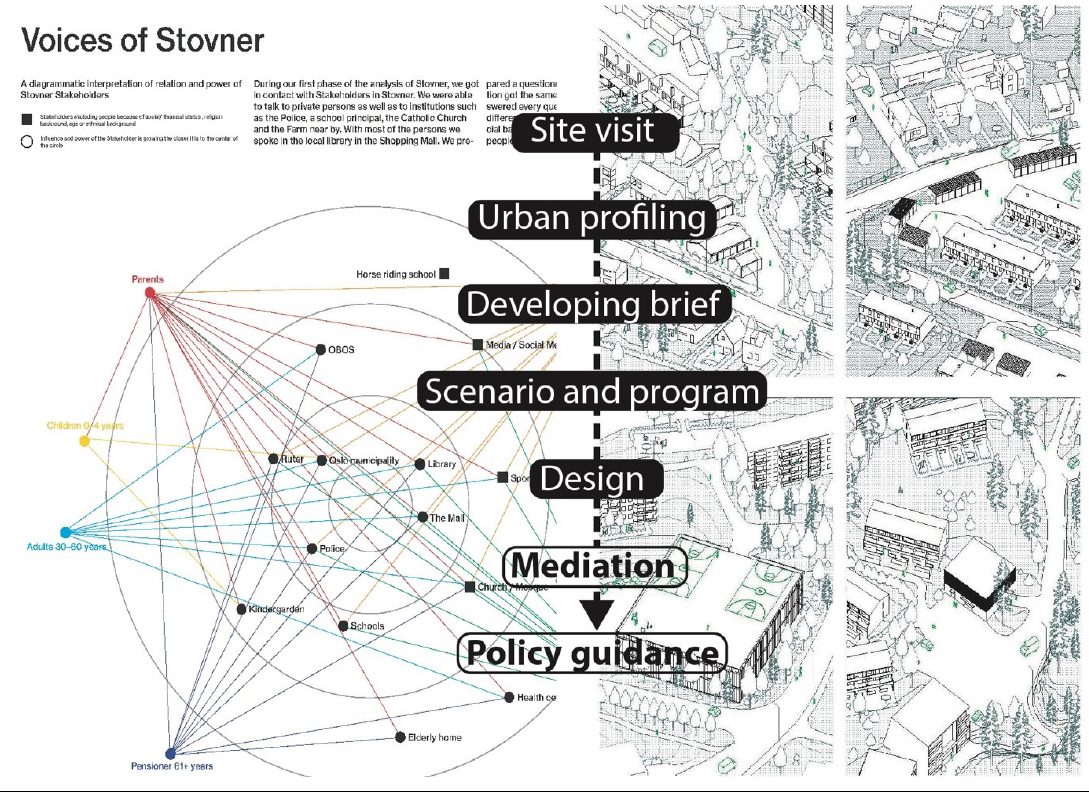
Figure 3. The In Transit Studio project phases (Source: photo composition by Peter Hemmersam; stakeholder mapping diagram by Ann Sophie Megerle; proposal for dispersed social spaces for youth in Stovner by Kristofer